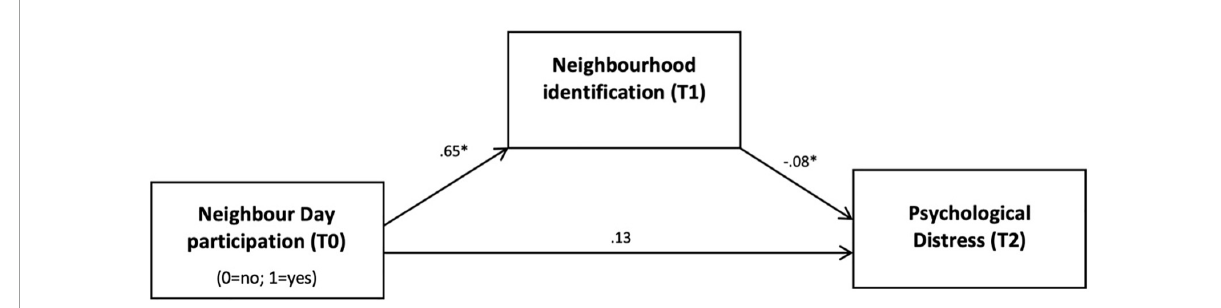
FIGURE2 Neighbour Day participation protects against distress following COVID lockdown via neighbourhood identification. N = 440. Indirect effect was significant, –0.05 (–0.10, –0.01). Standardised beta coefficients are provided for each pathway in the model, ∗ p < 0.05. Total effect was non-significant, β = 0.08, p = 0.334. Covariates included were psychological distress at T1, age, gender, relationship status, employment status, education, and neighbourhood socioeconomic